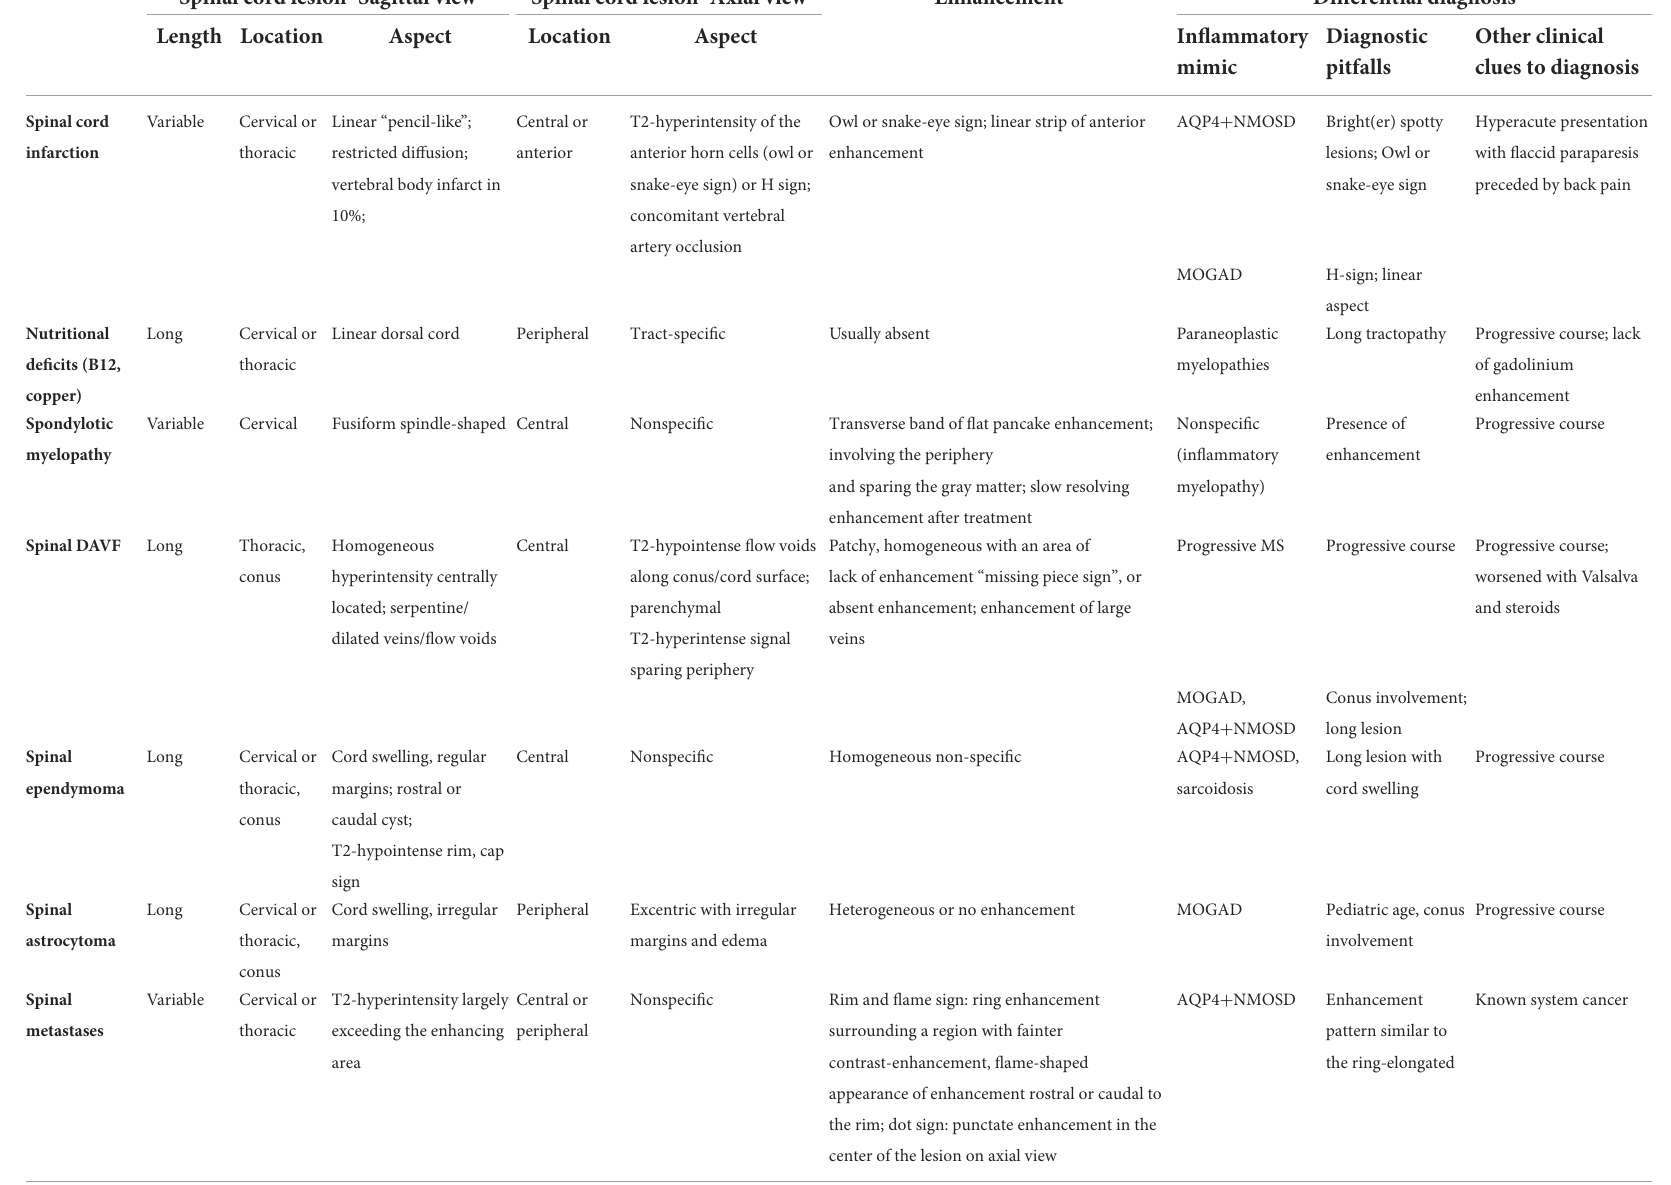
TABLE 3 Radiological features of the main mimics of inflammatory